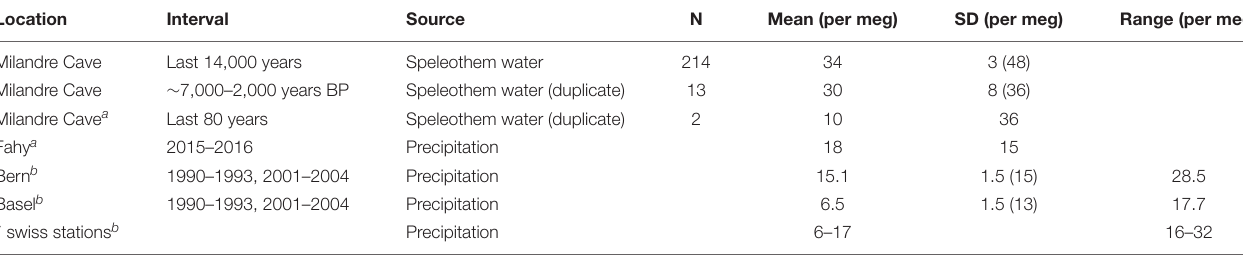
TABLE 2 | Mean 17 O excess values obtained for different time interval and sources.